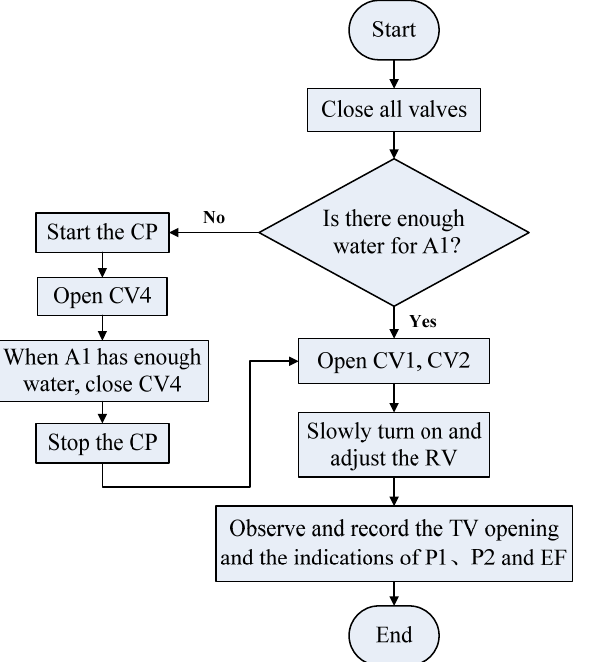
Figure 8. Test flowchart of the resistance characteristics of the dual disc check valve in the opening process.